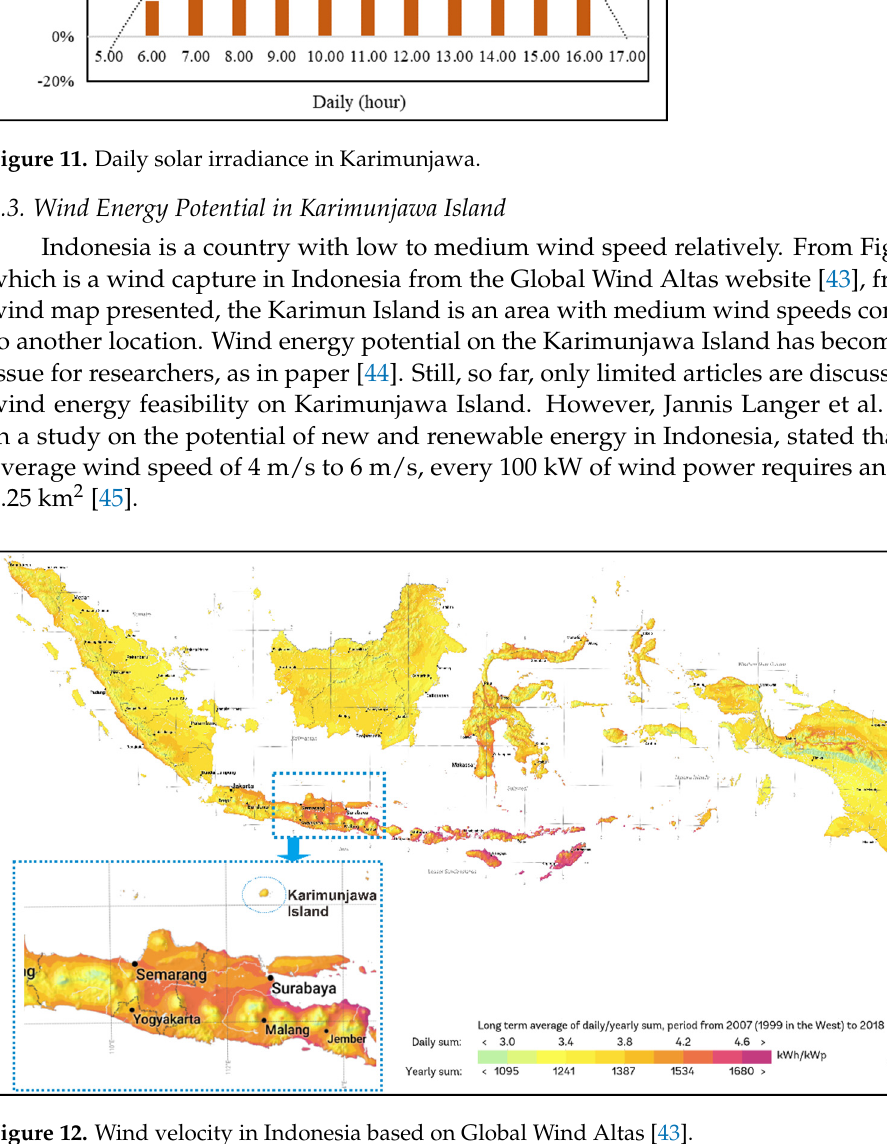
Figure 12. Wind velocity in Indonesia based on Global Wind Altas [43].